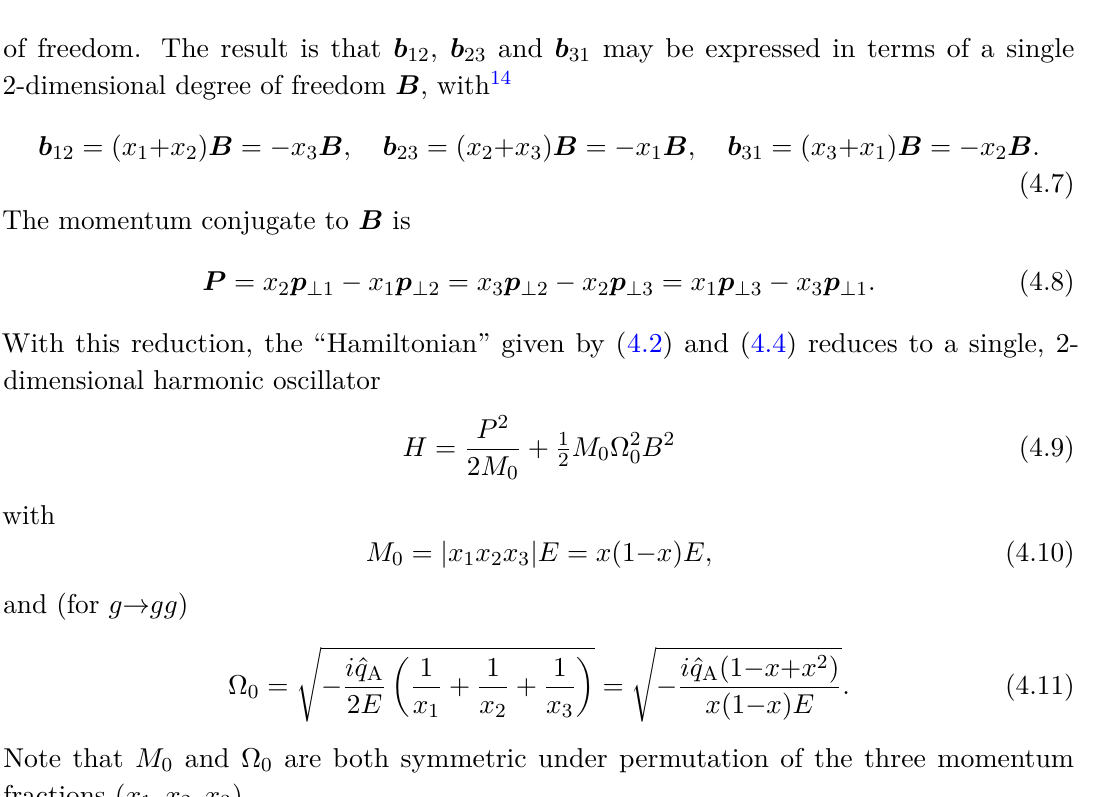
Figure 9 . The hard splitting rate. The shaded region indicates the region of time evolution between the two vertices, which is described by the 2-dimensional “quantum mechanics” Hamiltonian H